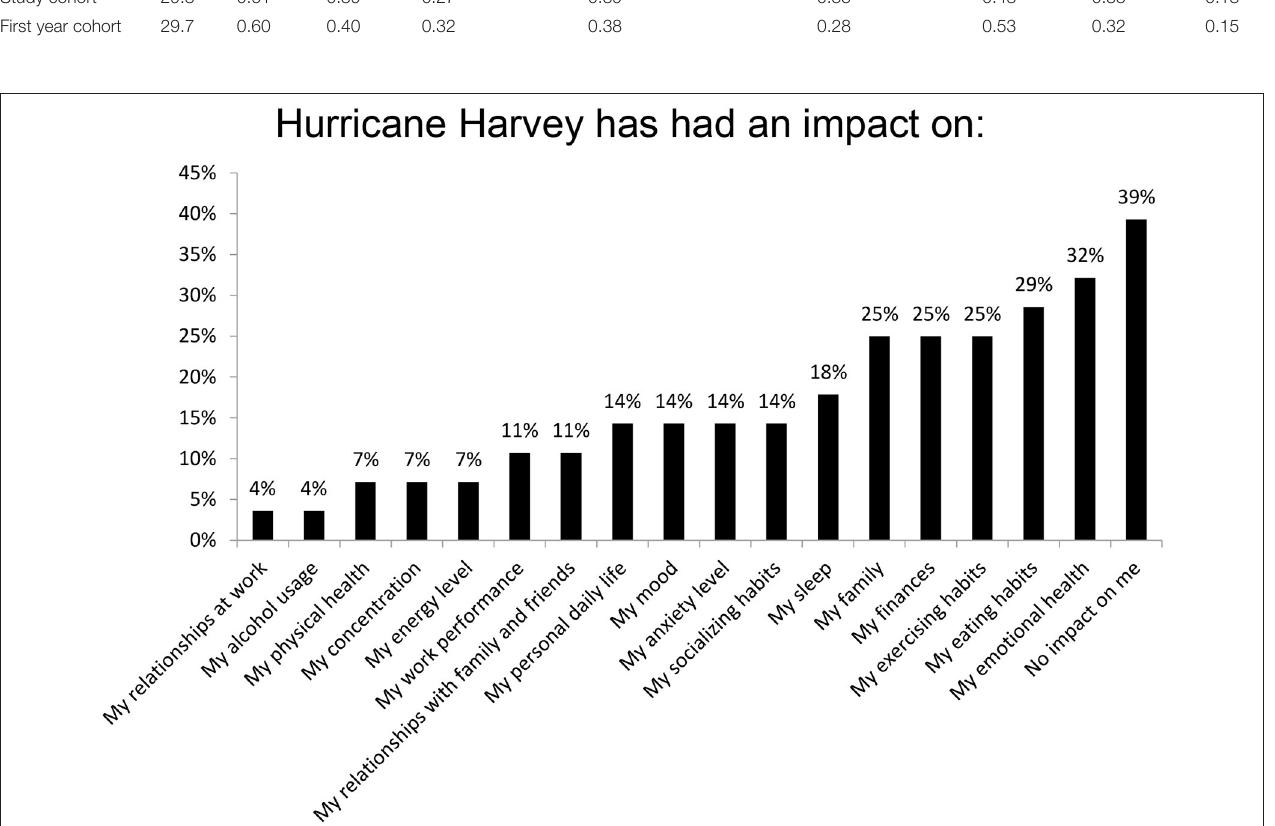
FIGURE 2 | Impact of Hurricane Harvey on new trainees. Survey responders were able to choose any and all of the options which applied to